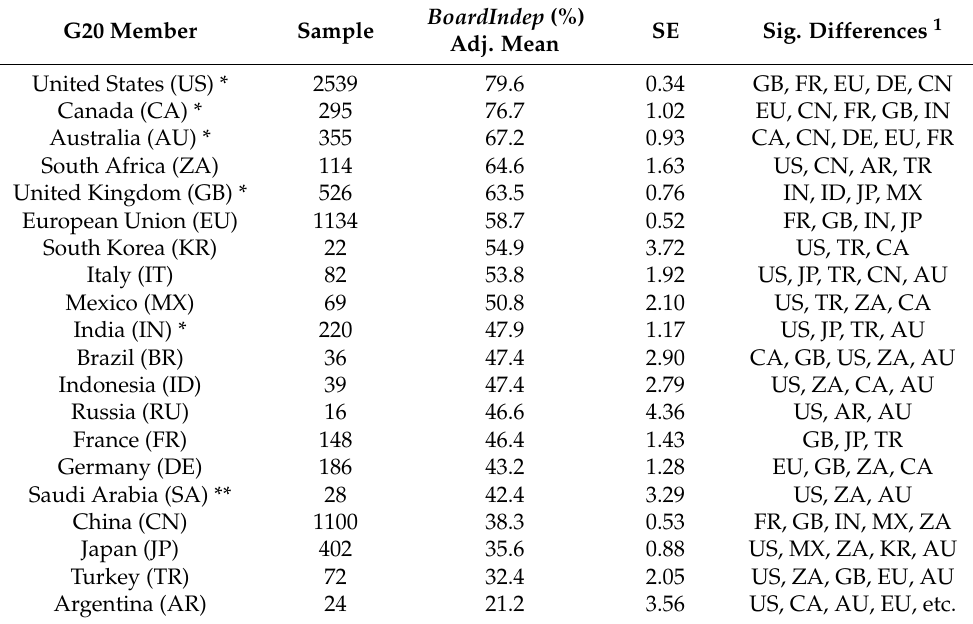
Table 5. The analysis of covariance of BoardIndep by country/group of countries, adjusted for company size, in descending